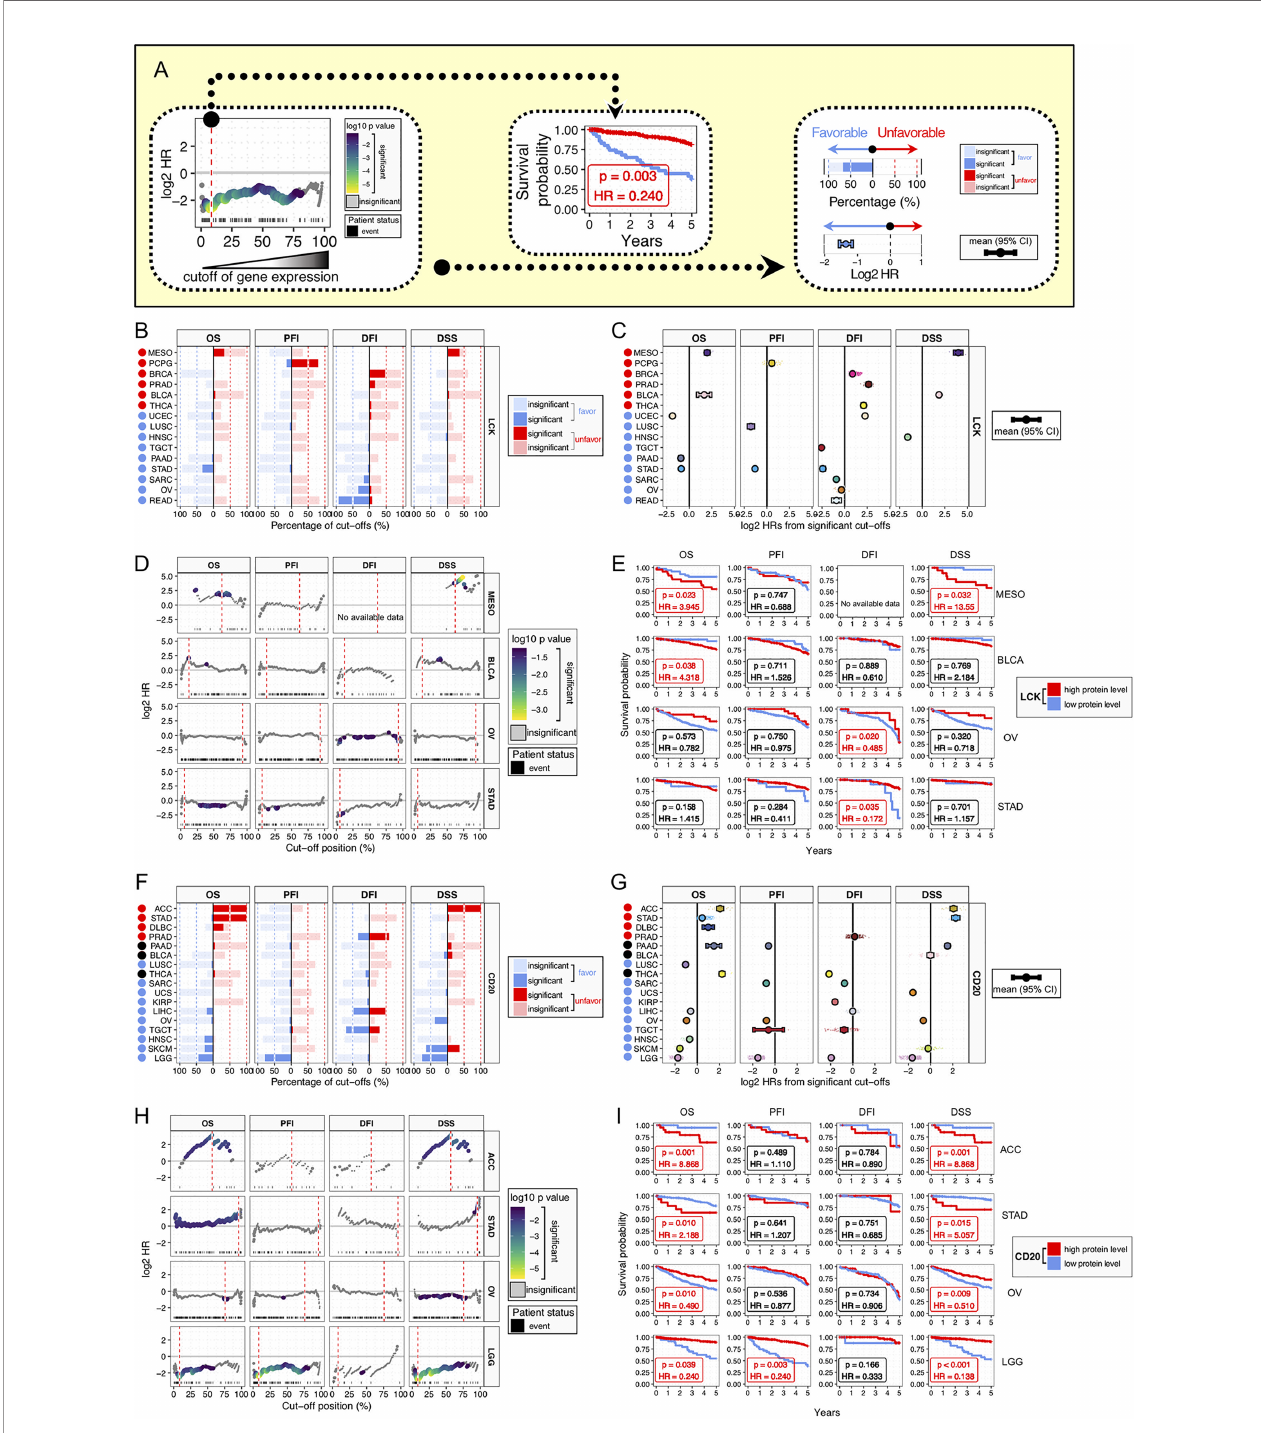
FIGURE 4 | Prognostic signi fi cance of LCK and CD20 across cancer types. (A) Analysis framework of prognostic relevance. Patients were separated into two groups according to all the possible cut-offs of protein levels. Each subgroup should have at least 15 patients. Multivariate Cox proportional-hazards regression analysis was performed for each possible cut-off, with covariates including age, gender, histological grade, and stage. (B, F) Bar plots of the percentages of favorable and unfavorable cut-offs by the protein levels of LCK (B) and CD20 (F) across different cancer types and four clinical outcomes of OS, PFI, DFI, and DSS. (C, G) Distributions of HRs for signi fi cant cut-offs. Error bars show mean ± 95% CI. (D, H) Plots of HRs for individual cut-offs by the protein levels of LCK (D) and CD20 (H) , with color indicating p -value. The best cut-off is indicated by red dashed line. (E, I) Kaplan-Meier plots for patient strati fi cation using the best cut-off of LCK (E) and CD20 (I)